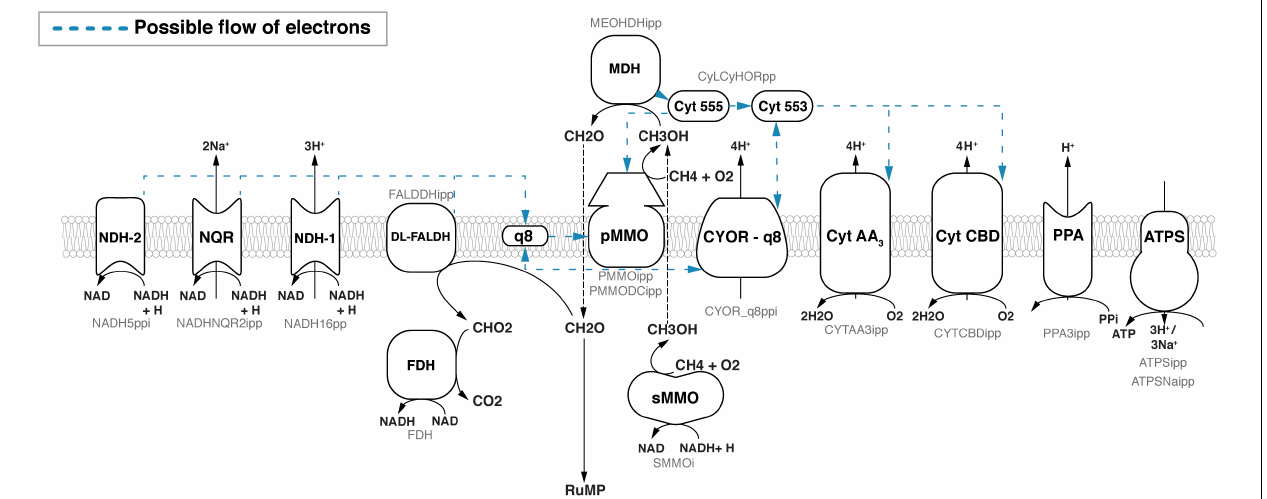
FIGURE 1 | Overview of the respiratory chain in Methylococcus capsulatus Bath as implemented in iMcBath. Black text in the center of the symbols denotes the common abbreviation, while the faint gray text below denotes the corresponding reaction ID in the metabolic model. Blue dotted arrows indicate possible flow of electrons between respiratory components. The individual electron transfer modes to the pMMO are outlined in greater detail in Figure 2 .